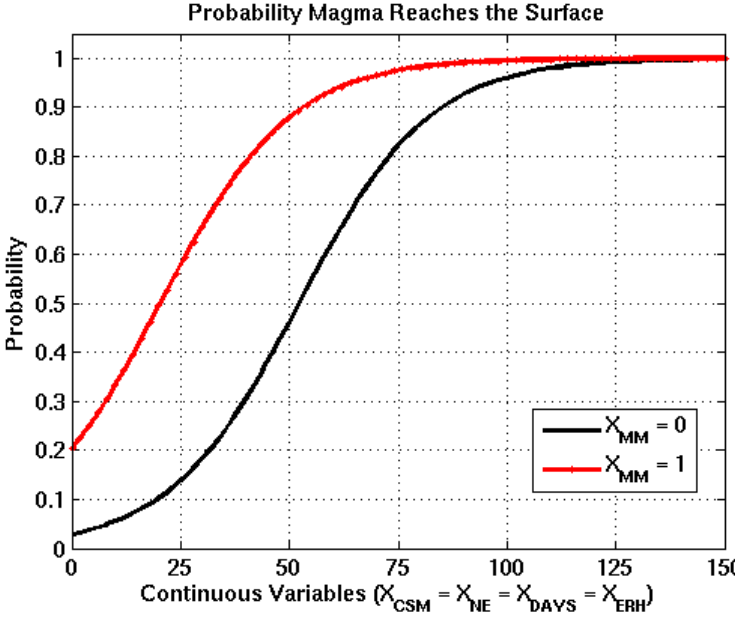
= 0 and X = 1 . The transition of X MM MM MM